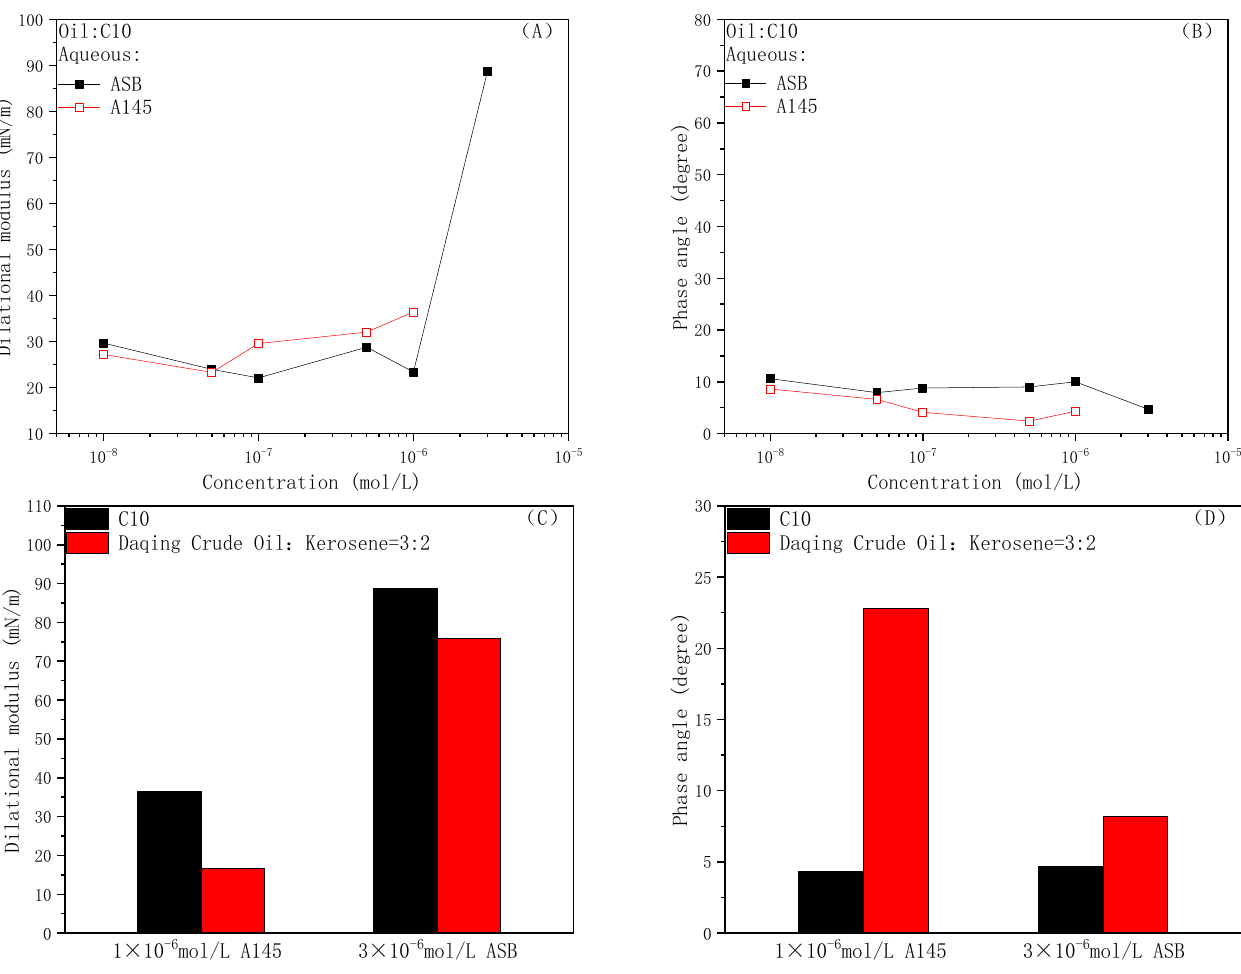
Figure 2. Interface dilational modulus ( A ) and phase angle ( B ) of ASB and A145 solutions against n-decane and diluted oil as a function of surfactants concentration, comparison of the dilational modulus ( C ) and phase angle ( D ) of surfactants with n-decane and diluted crude oil at the same concentration.